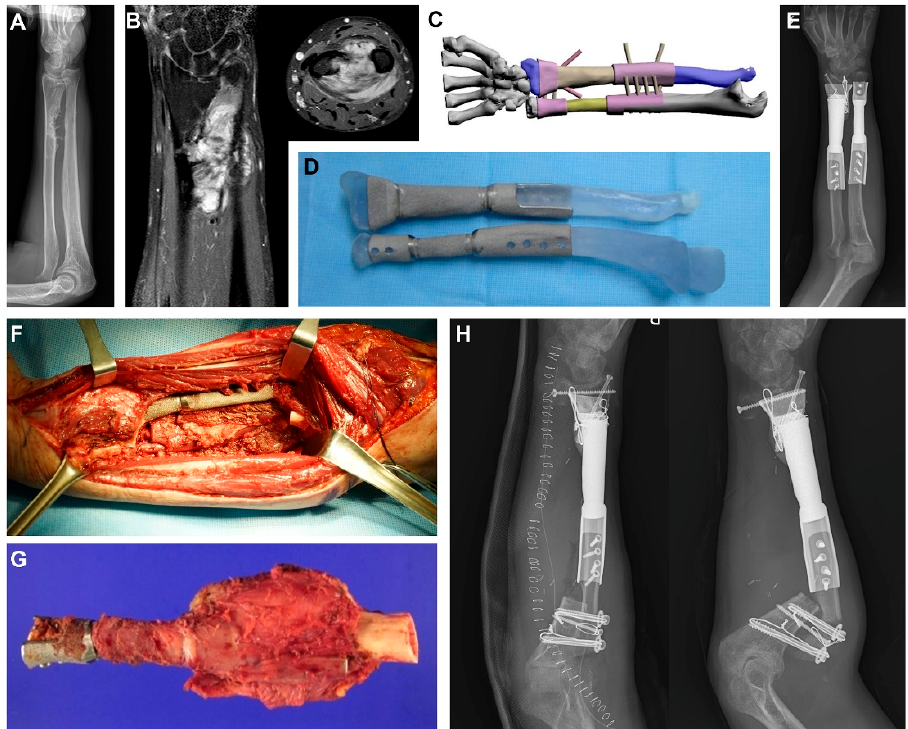
Figure 1. Failure of the 3D-printed implants in both forearm bones [14] . ( A ) A preoperative plain radiography and ( B ) gadolinium-enhanced T1-weighted magnetic resonance image showing desmoplastic fibroma arising from both forearm bones. ( C ) A graphic design and ( D ) photograph of 3D-printed implants. ( E ) A postoperative plain radiograph after limb salvage surgery. Photographs showing ( F ) removal of the ulnar implant with a recurrent tumor and ( G ) a specimen. ( H ) Plain radiographs showing immediate postoperative status after the first revision surgery ( left ) and mechanical failure 4 months later ( right ).